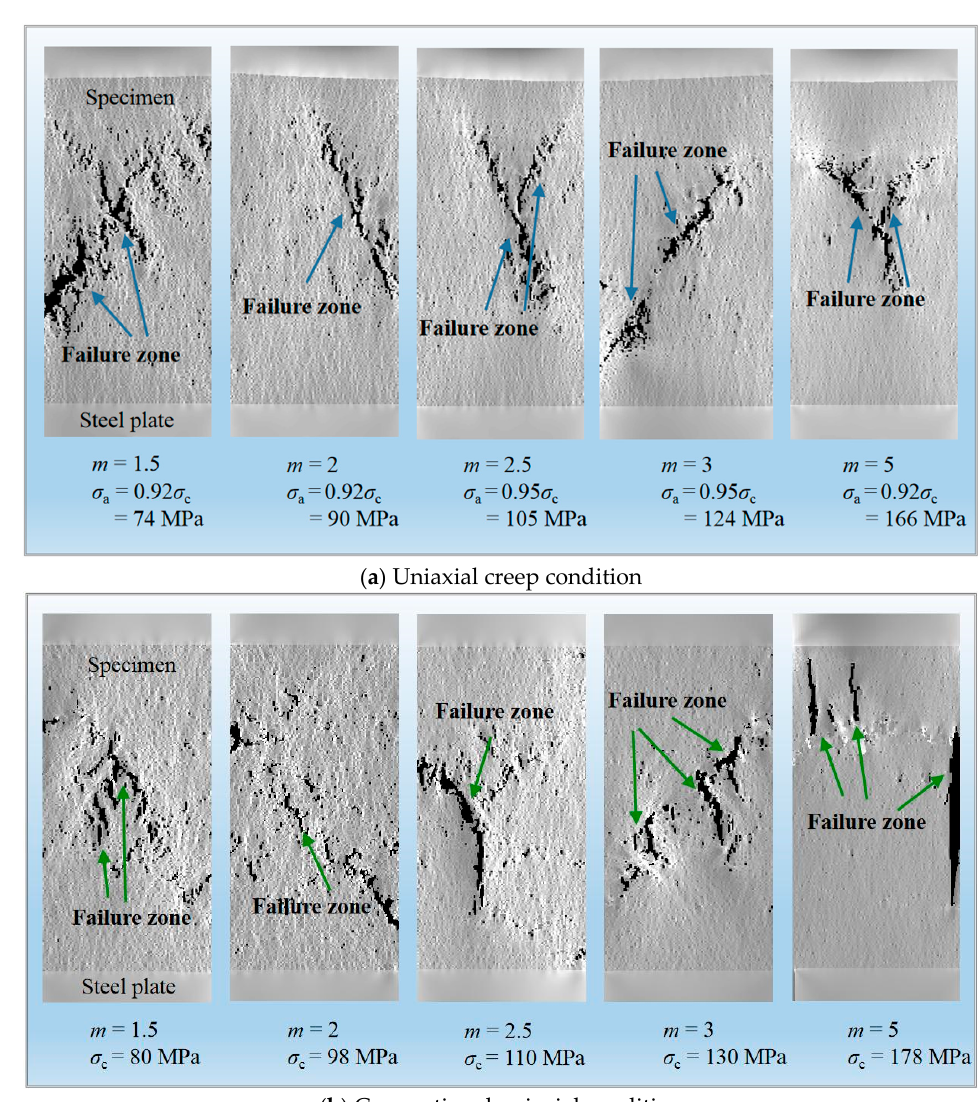
Figure 18. Damage accumulation for various homogeneity indexes under uniaxial creep ( a ) and conventional compression conditions ( b ).